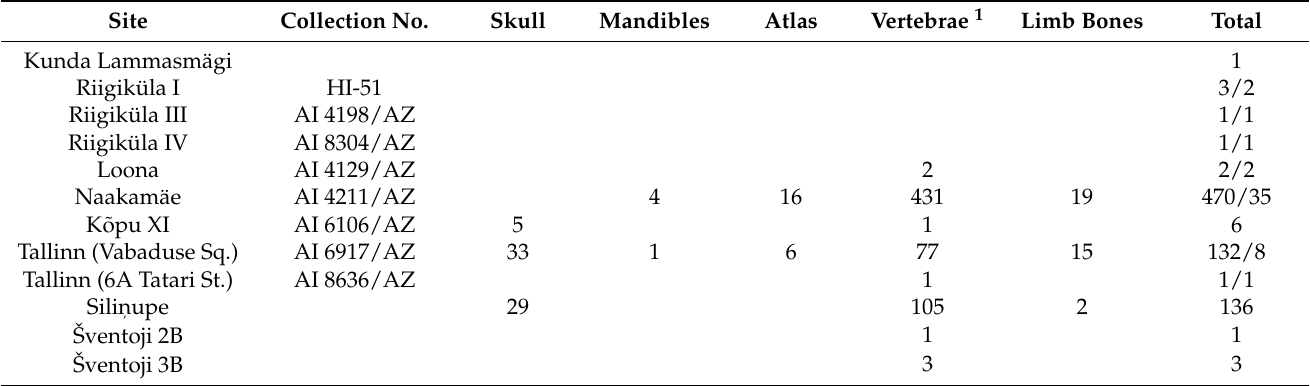
Table 1. Bone finds of harbor porpoise ( Phocoena phocoena ) from archaeological sites of Estonia, Latvia and Lithuania. NISP (number of identified specimens) is presented, and where available, the MNI (minimum number of individuals) is added (values separated by